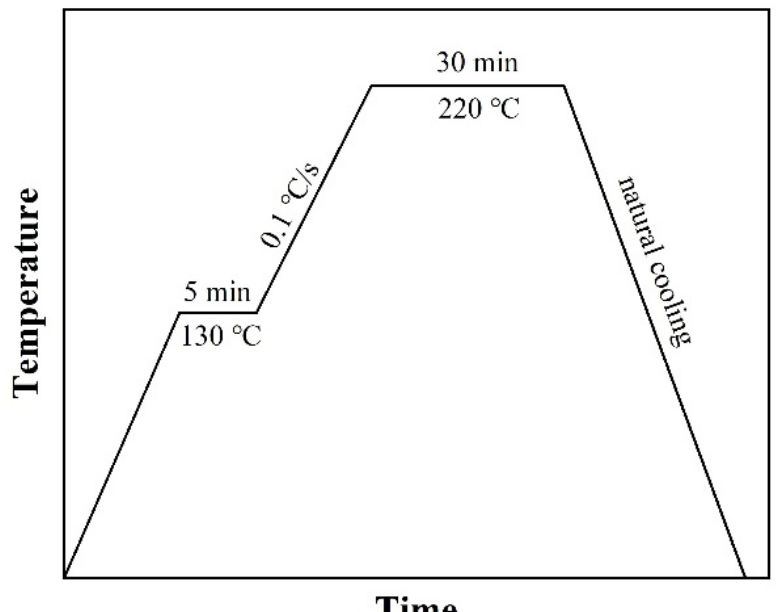
Figure 2. A typical temperature curve during the sintering process.